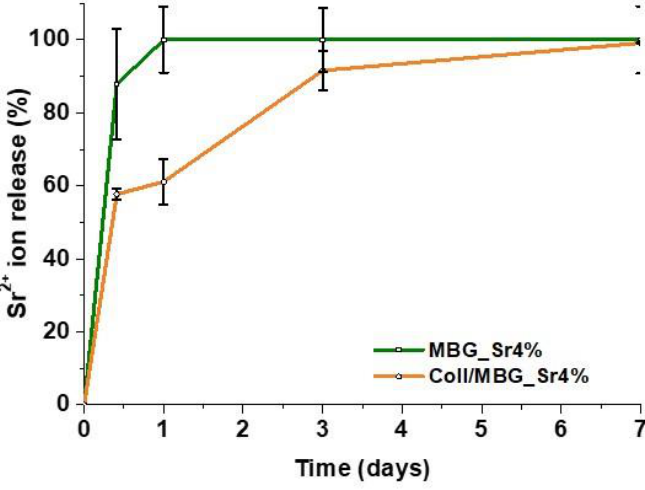
Figure 3. Sr 2+ ion release from MBG_Sr4% particles and the Coll/MBG_Sr4% system.